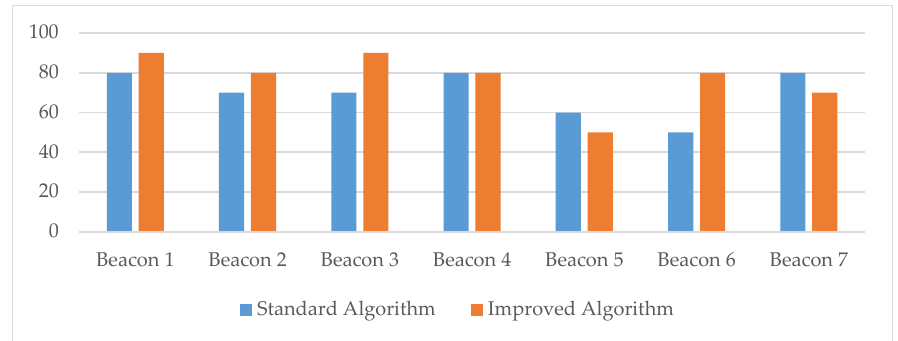
Figure 14. The success rate of correct transmitter detections for the controlled room environment with a low or no density of obstacles.